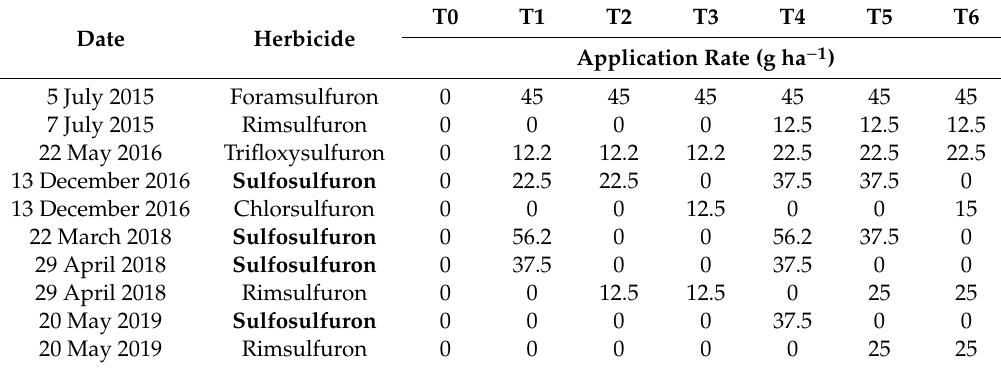
Table 2. Multi-year schemes of sulfonylurea treatments in a controlled environment and in the field.